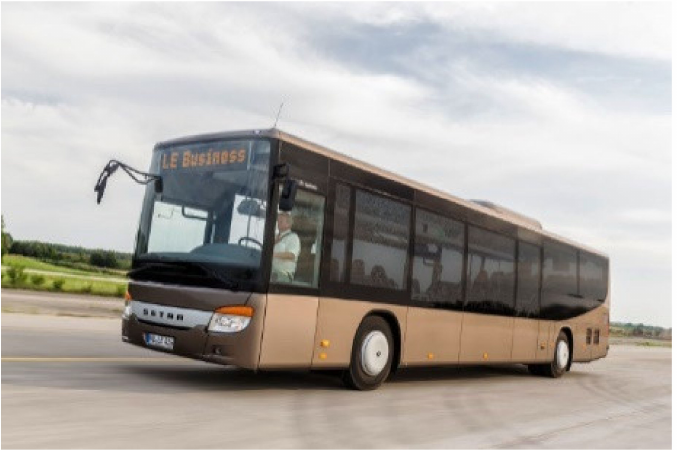
Figure 18. Serta Multiclass S 415 LE